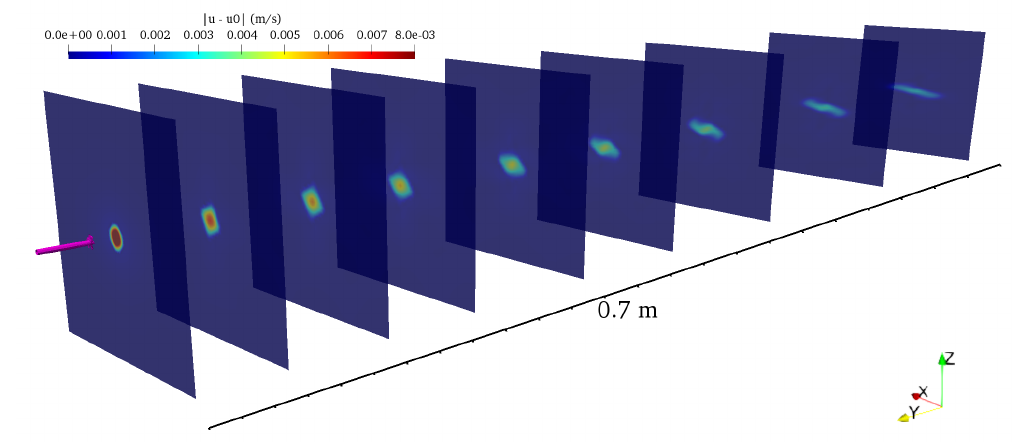
Figure 3. Visualisations of flow speed perturbation at t = 200 s. This illustrates the generation, growth, and collapse stages of the mixed patch as the wake propagates downstream. All cross-sections were taken in the x – z plane up to 0.7 m downstream of the propeller’s hub (i.e., up to y = length of the domain is not shown. The propeller system is coloured